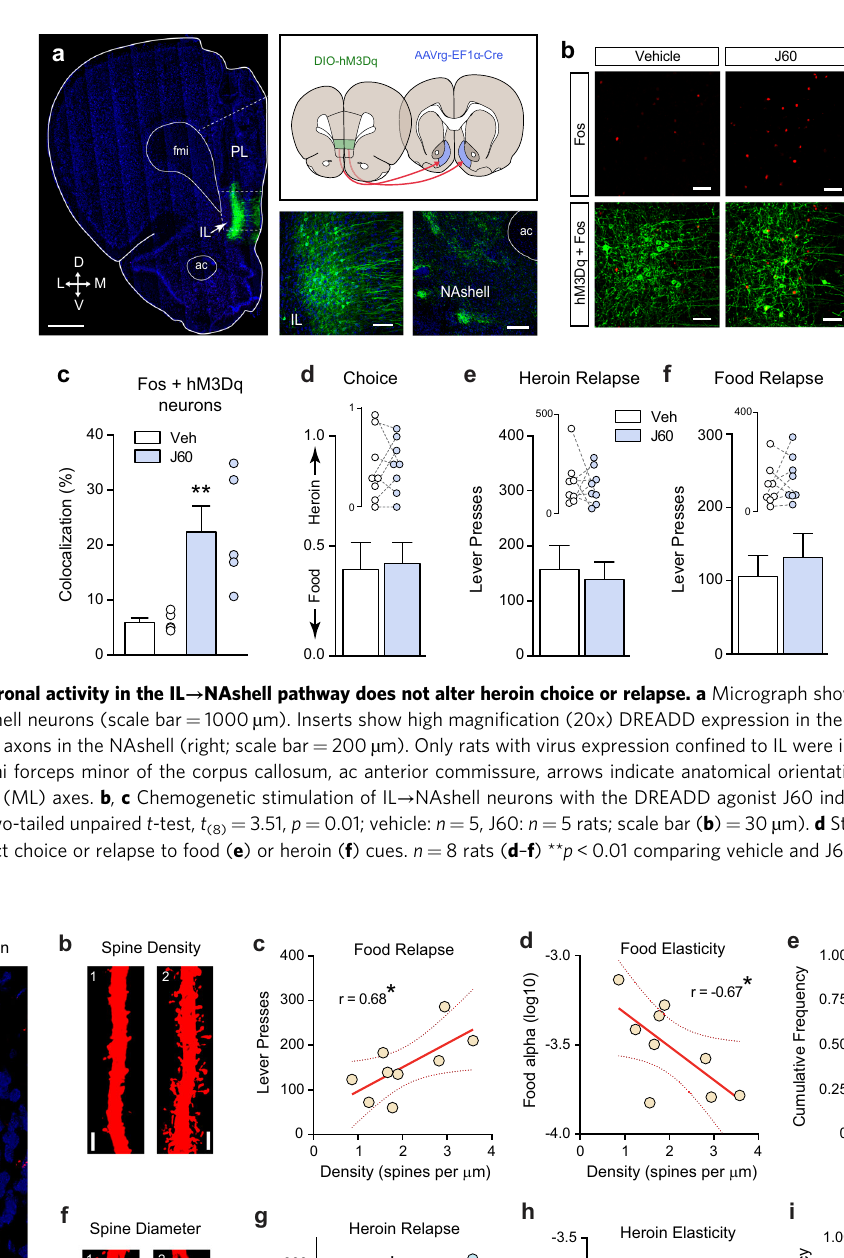
NATURE COMMUNICATIONS| (2021) 12:4788